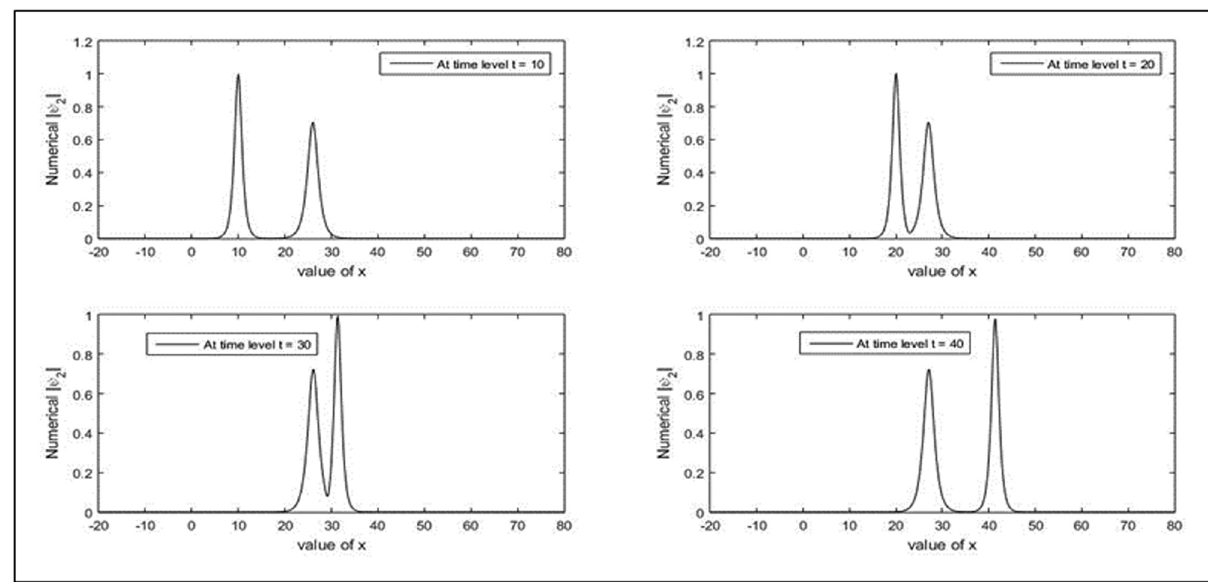
Figure 8: Interaction of two solitons for second - wave amplitude for = N 501 , = τ 1 [ −20, 80 ] .